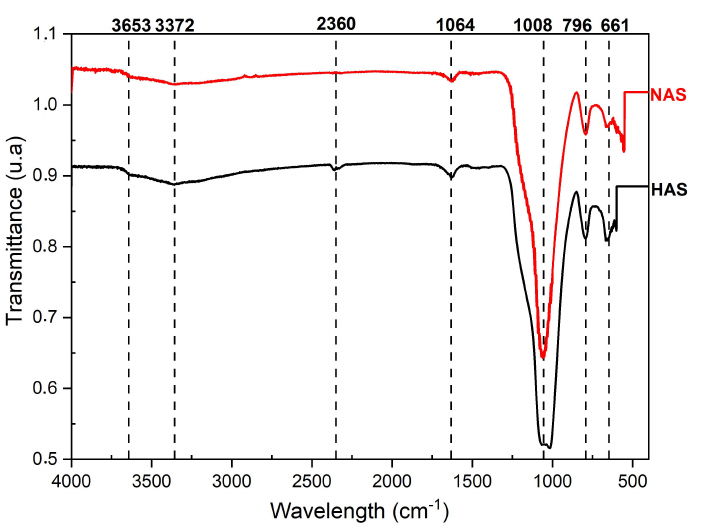
Figure 2. FTIR spectrum of NAS and HAS synthesized clays.